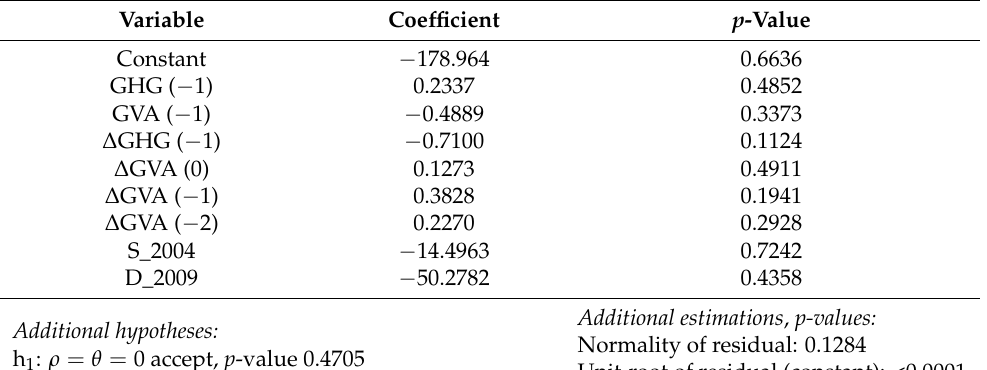
Table 5. Autoregressive distributed lag (ARDL) results for